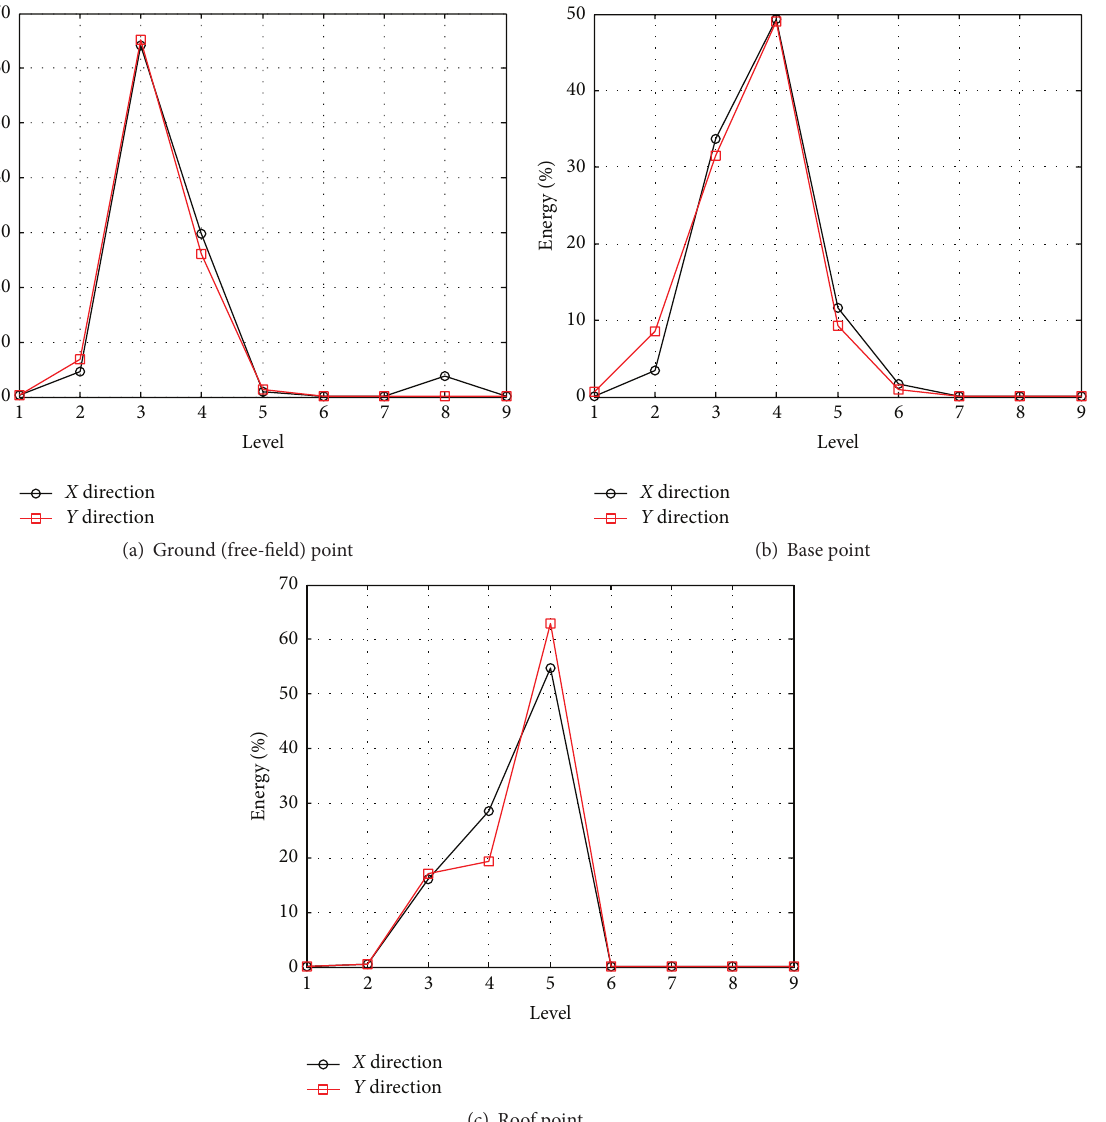
Figure 15: Energy distribution of the decomposition levels of the measurements points during the